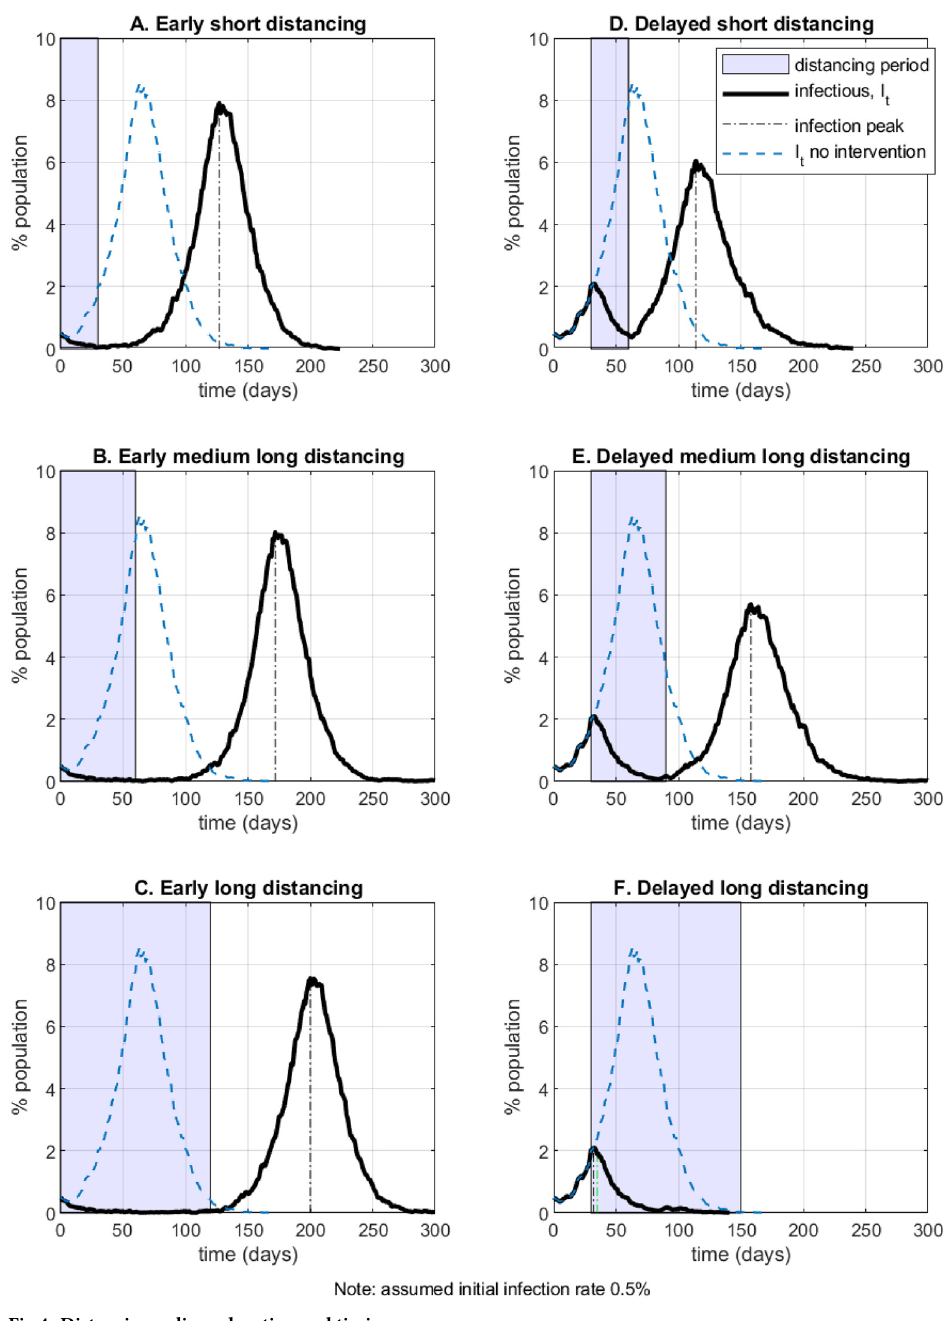
Fig 4. Distancing policy—duration and